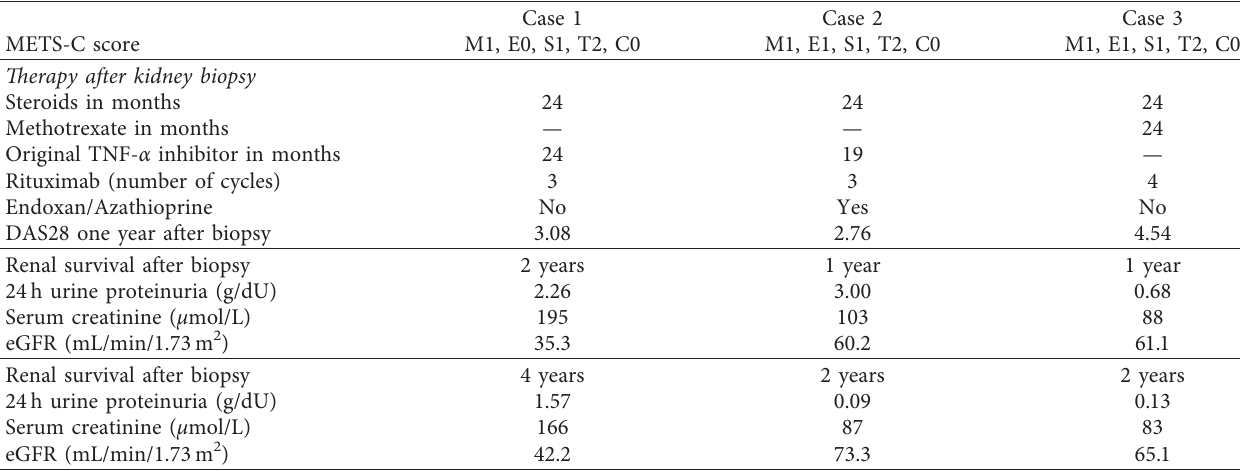
Table 2: Clinical characteristics and renal survival of three RA patients with IgA glomerulonephritis following kidney